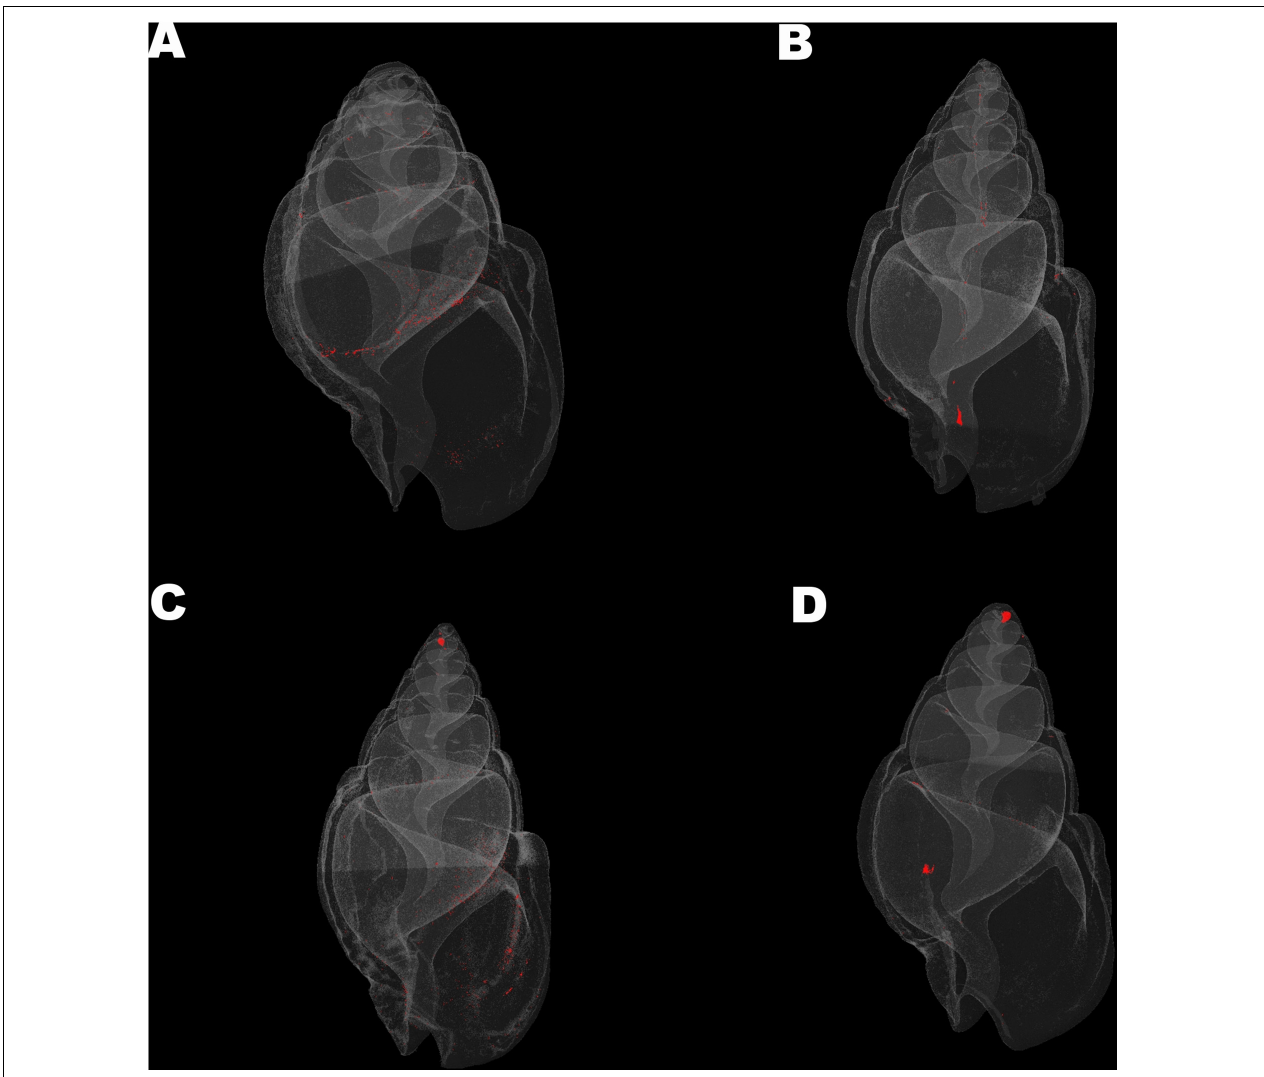
FIGURE 3 | Visualization of shell closed porosity for Nassarius nitidus in the four experimental treatments (A) (7A), (B) (8A), (C) (7W), and (D) (8W) as coded in the text (8A: 20 ◦ C and pH = 8; 7A: 20 ◦ C and pH = 7.7; 8W: 23 ◦ C and pH = 8; 7W: 23 ◦ C and pH =